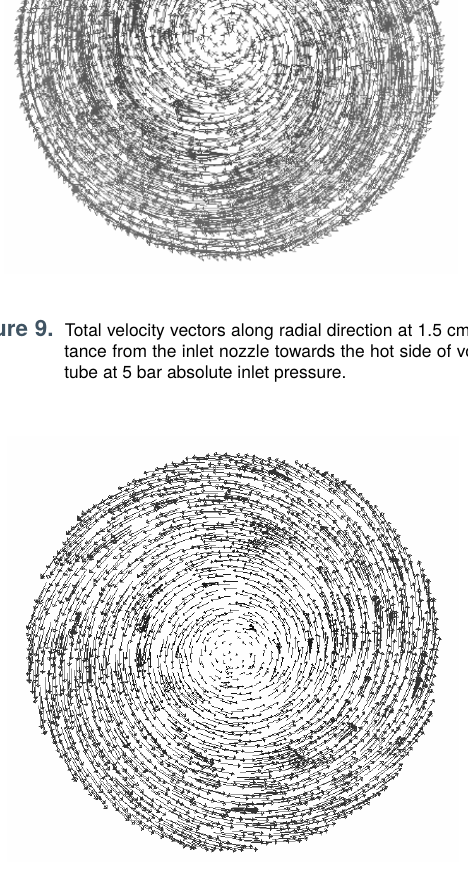
Figure 10. Total velocity vectors along radial direction at 7 cm dis- tance from the inlet nozzle towards hot side of vortex tube at 5 bar absolute inlet